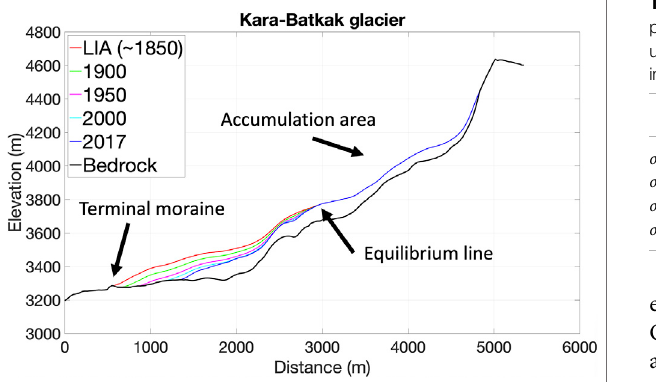
TABLE 5 | Uncertainty ofthe modelled massbalances. σ par :uncertainty tovarying parameter values, σ clim : uncertainty to meteorological input data, σ cal